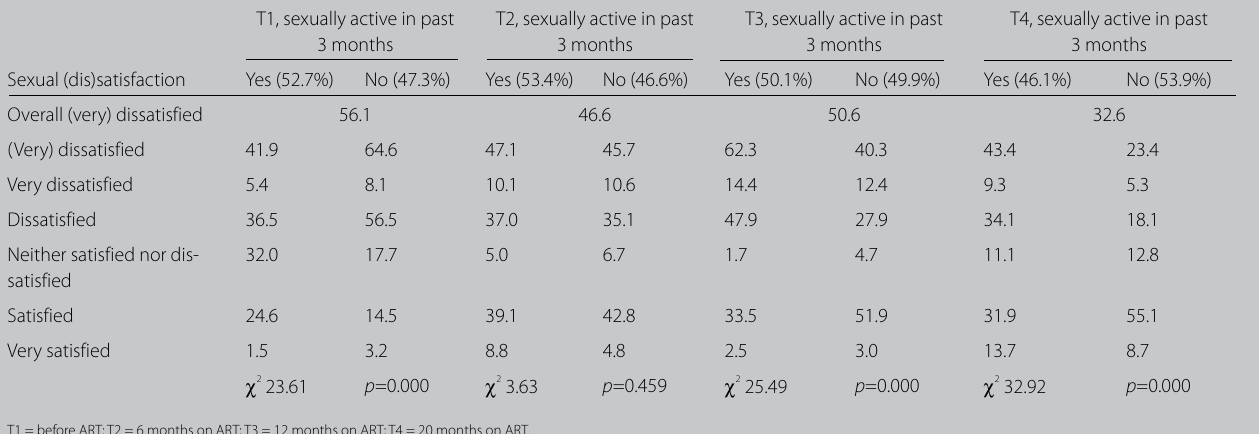
Table II. Sexual activity and sexual dissatisfaction ( N =495) (%) T1, sexually active in